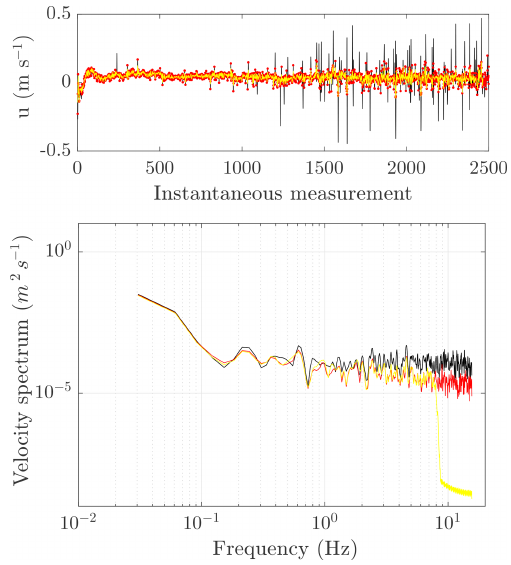
Figure 2. Raw velocity data (black) and despiked data (red) ob- tained with the procedure proposed by Goring and Nikora (2002). Then, through the analysis of the velocity spectra (bottom), the cut- off frequency of 8Hz has been identified in order to low-pass filter the noisy frequencies (yellow line).